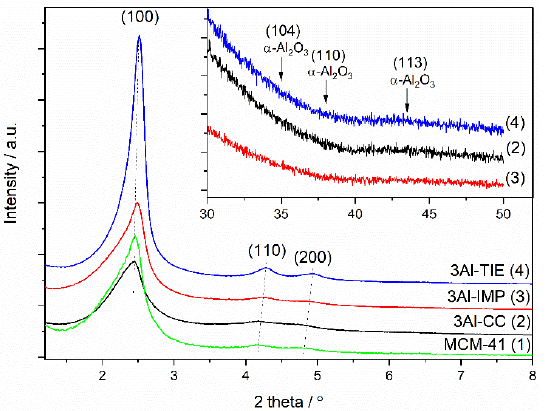
Figure 1. X-ray diffractograms of MCM-41 modified with aluminum using different